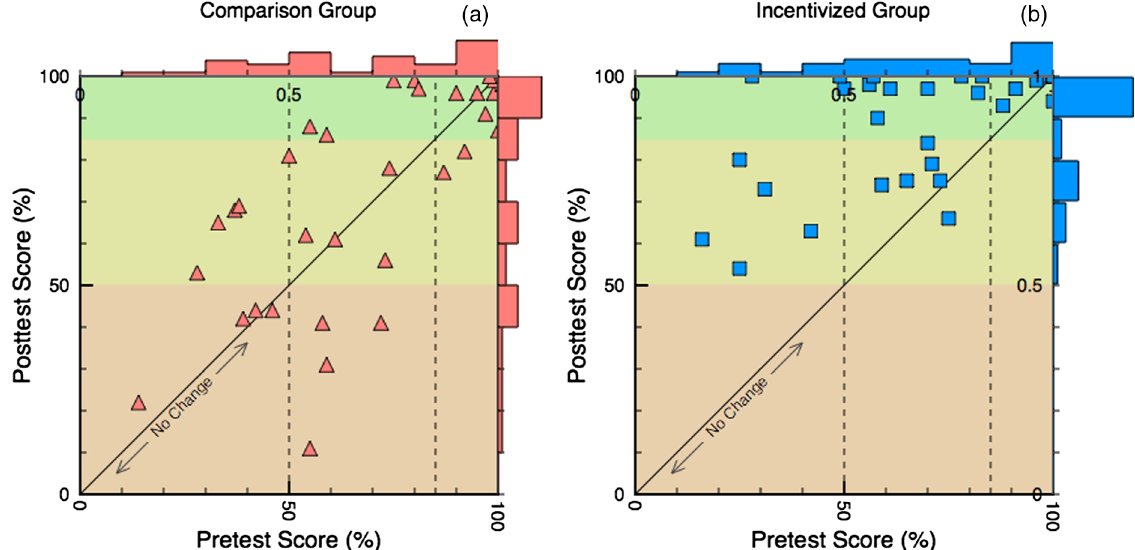
FIG. 2. Average pretest vs posttest score for each student on the four questions repeated from the pretest to the posttest in the comparison group and incentivized group. Red-filled triangles are used for each student from the comparison group and the blue-filled squares are for each student in the incentivized group. The histograms along each axis show the distribution of the pretest and posttest scores for the comparison group and the incentived group. A closer look at the histograms suggests that pre-intervention scores are similar for the comparison and incentivized group. However, the incentivized group ’ s posttest distribution has shifted out of the lower region, and is peaked near the high performance